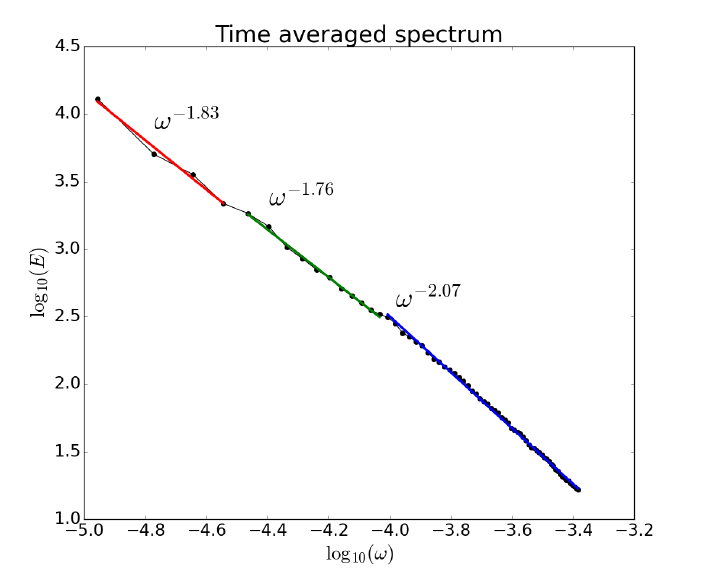
Figure 9. Energy spectrum of the temporal component of the Faraji effective temperature field. The exponents correspond to the spectral indices of the three different zones, highlighted by the scale